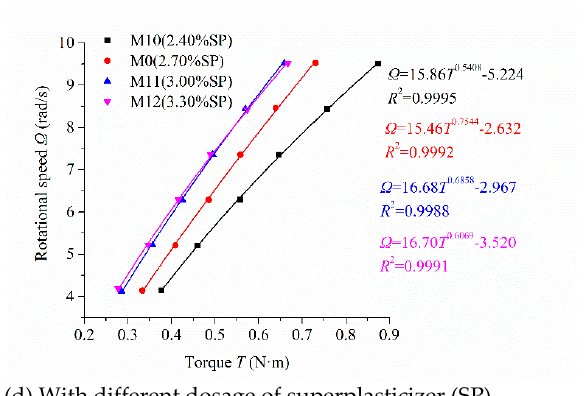
Figure 4. Relationship between the rotational speed and torque of mortars fitted by the new rheological model.